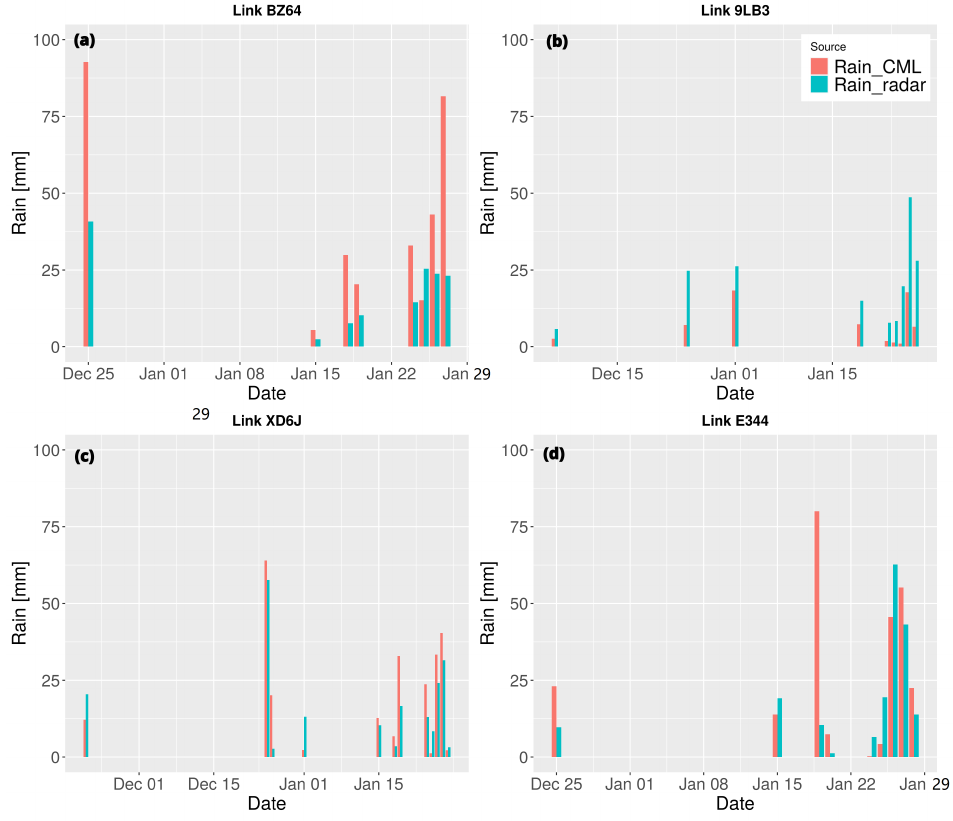
Figure 4. Four example links from Israel, with time-series comparisons between CML-derived rainfall and radar rainfall at the link location. The comparison period is from 1 November 2018 to 28 February 2019. Columns represent rainfall in mm/day. In ( a ), the link consistently over estimates daily rainfall; ( b ) shows a link that consistently underestimates rainfall. Plots ( c , d ) are links that display inconsistent errors compared to the radar